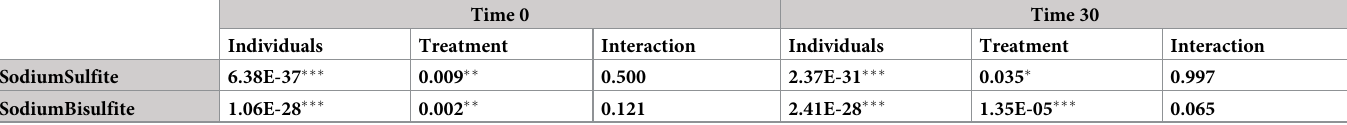
Table 1. “p-value” results of two-way ANOVA tests.